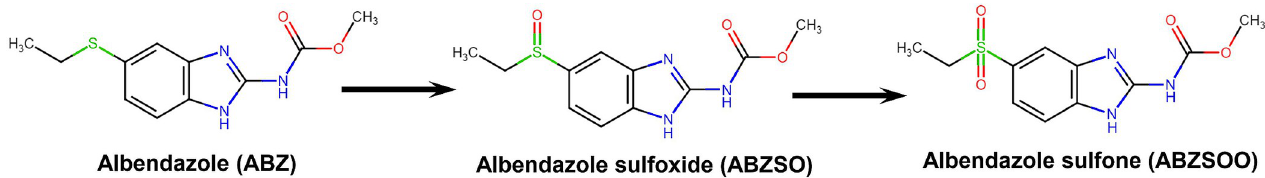
Fig 1. Chemical structure of ABZ, ABZSO, ABZSOO and schematic pathway of ABZ metabolism.